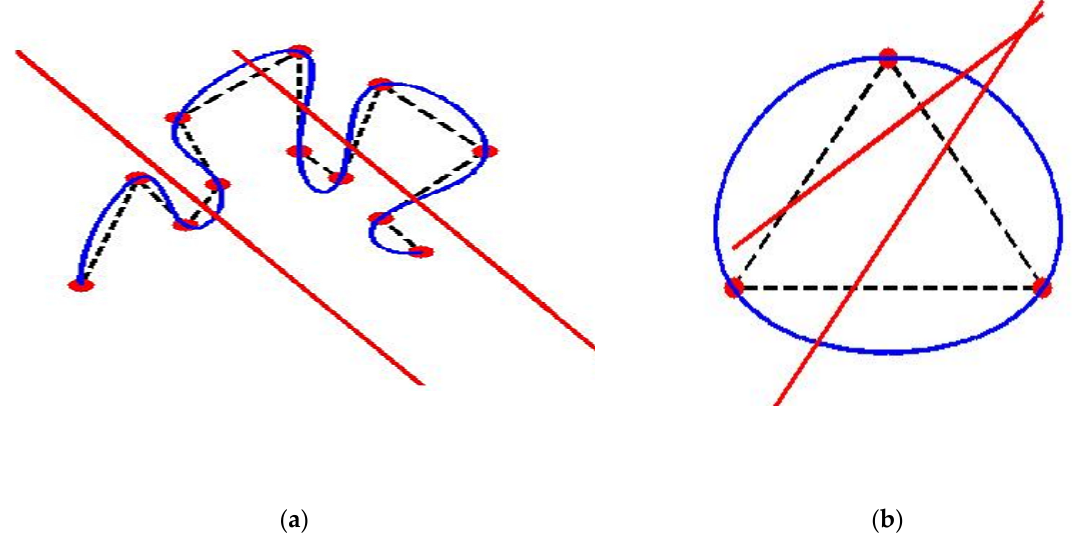
Figure 4. VD property for ( a ) an open curve and ( b ) a close curve.